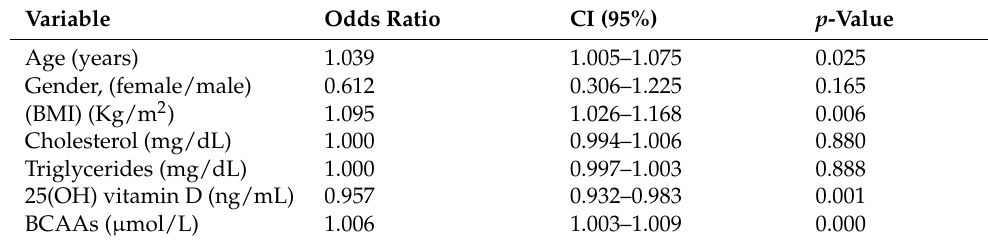
Table 2. Logistic regression analysis of the study variables.